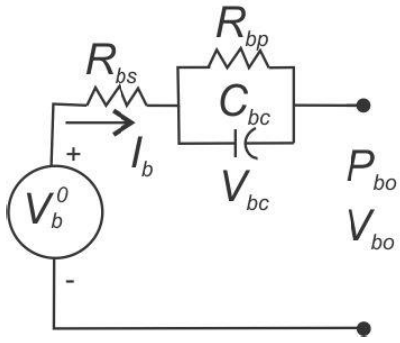
Figure 5. Battery electrical model.